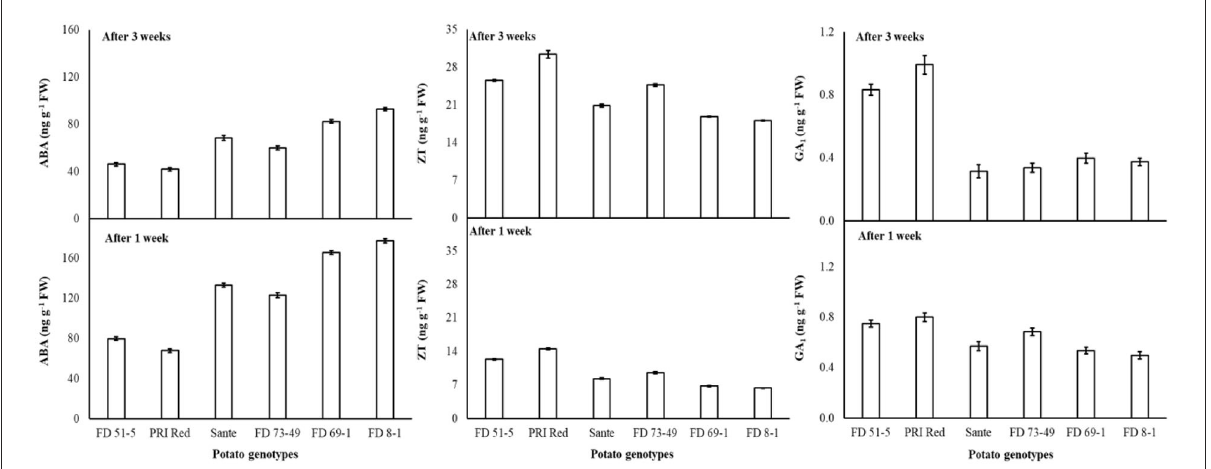
FIGURE5 Change in ABA, ZT, and GA 1 levels in tuber during storage period (3 weeks) following treatment with low temperature under cold storage. Vertical error bars represent standard error of means (n: 4).